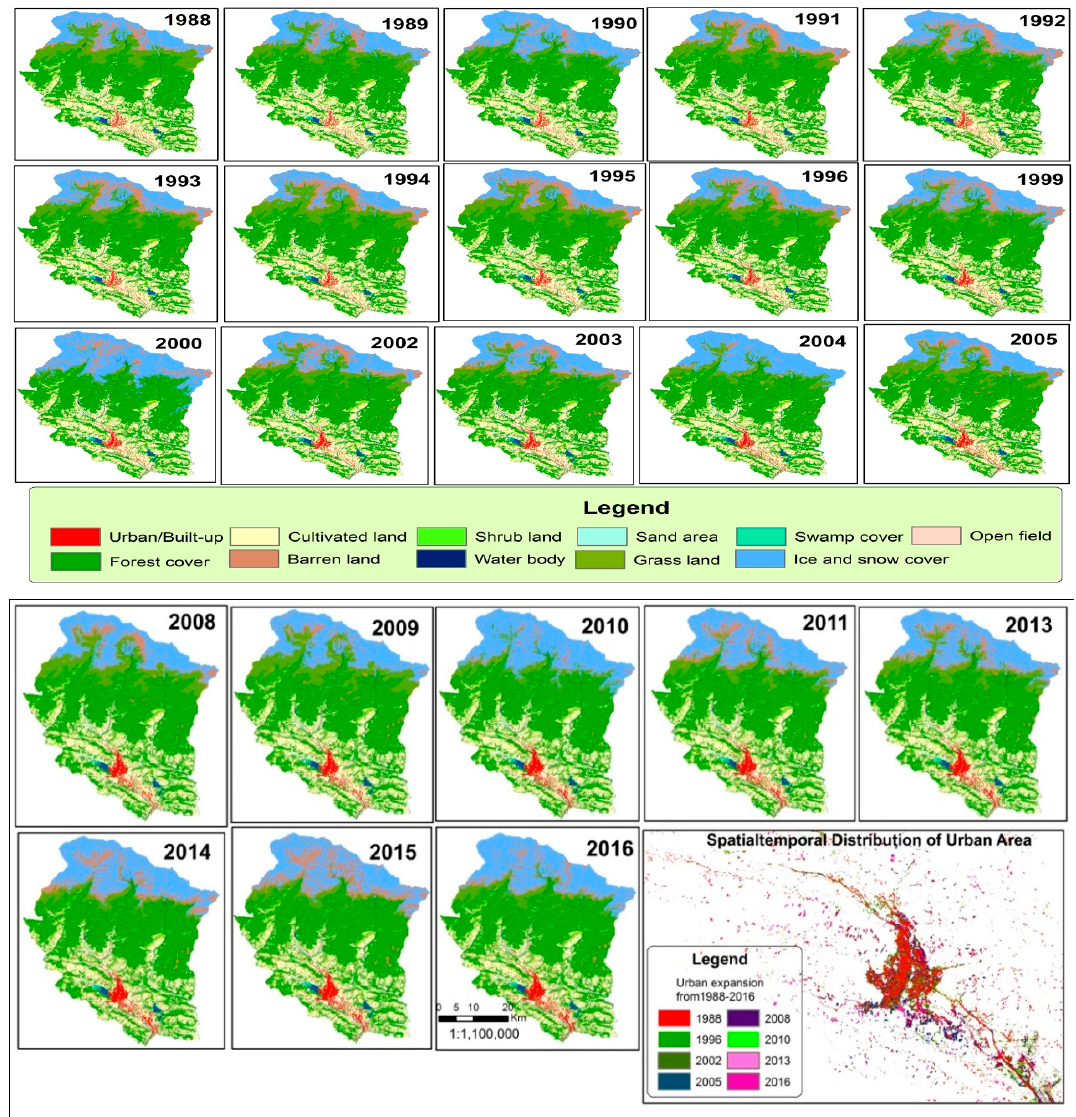
Figure 3. ( a ) LULC map for individual years from 1988 to 2016; ( b ) urban area from 1988 to 2016.